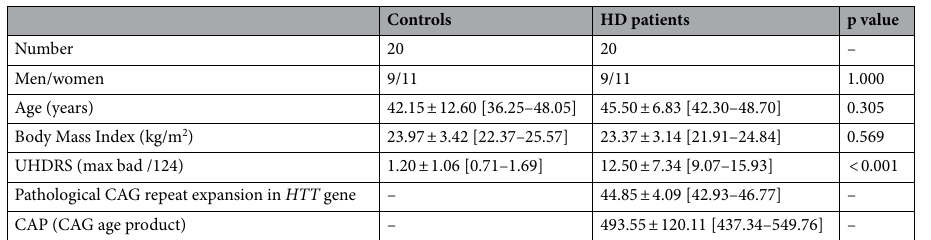
Table 2. Demographic parameters of recruited participants. Data are presented as mean ± standard deviation [95% confidence interval]. P values were calculated using Welch ANOVA and significance was set at alpha < 0.05. Differences in gender were calculated using chi-square